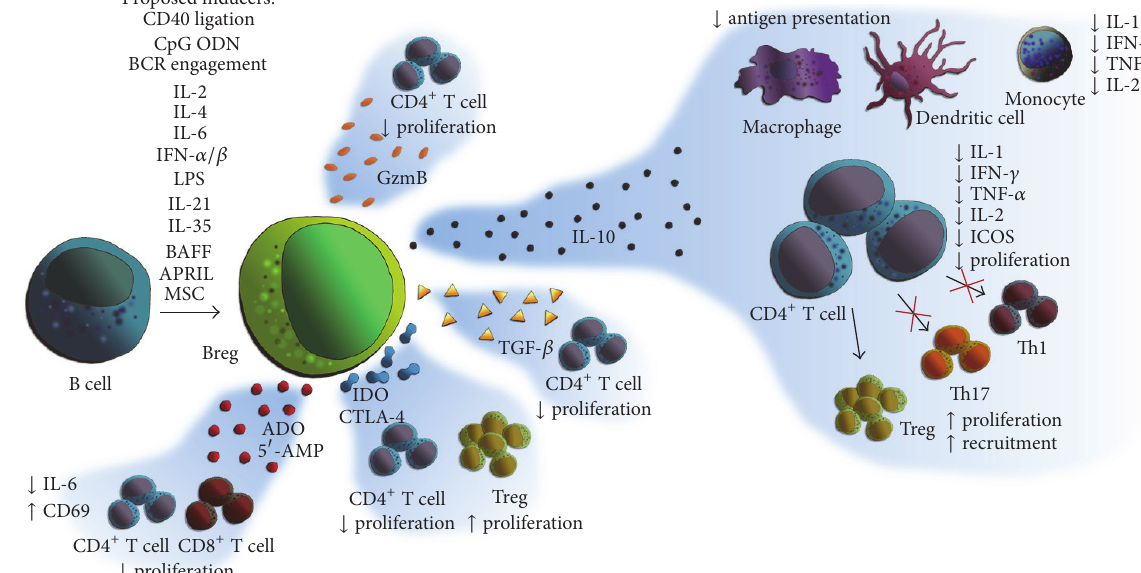
Figure 1: Graphical summary of the main Breg induction methods, mode of action, and immunosuppressive functions that have been proposed in the literature. ODN: oligodeoxynucleotides; IL: interleukin; BCR: B cell antigen receptor; IFN: interferon; LPS: lipopolysaccharide; BAFF: B cell activating factor; APRIL: a proliferation-inducing ligand; MSC: Mesenchymal Stem Cells; GzmB: granzyme B; TGF: transforming growth factor; ADO: adenosine; AMP: adenosine monophosphate; IDO: indoleamine 2,3-dioxygenase; CTLA-4: Cytotoxic T-Lymphocyte Antigen 4; ICOS: inducible T cell